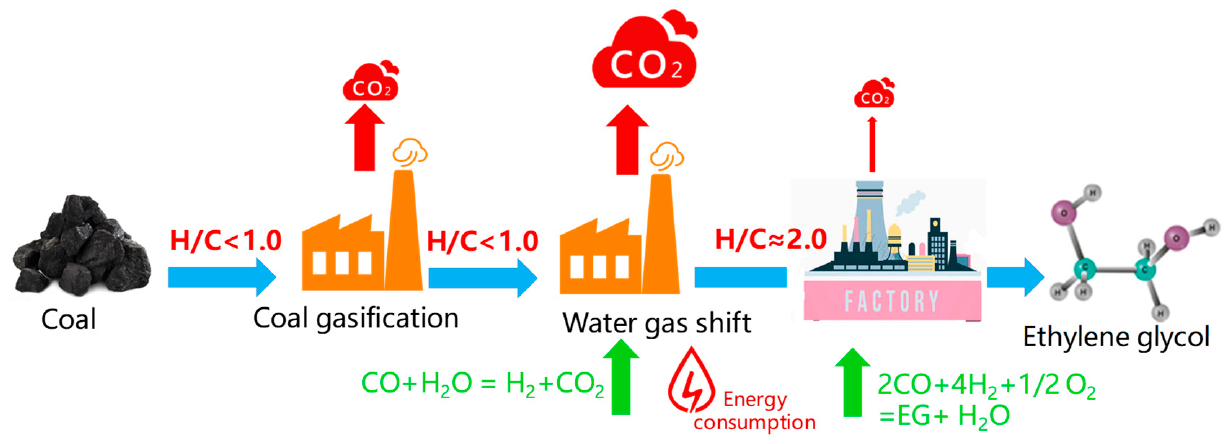
Figure 1. Schematic diagram of the high CO 2 emission reasons for coal to ethylene glycol (CTEG) process. Carbon dioxide is one of the greenhouse gases causing global warming, which